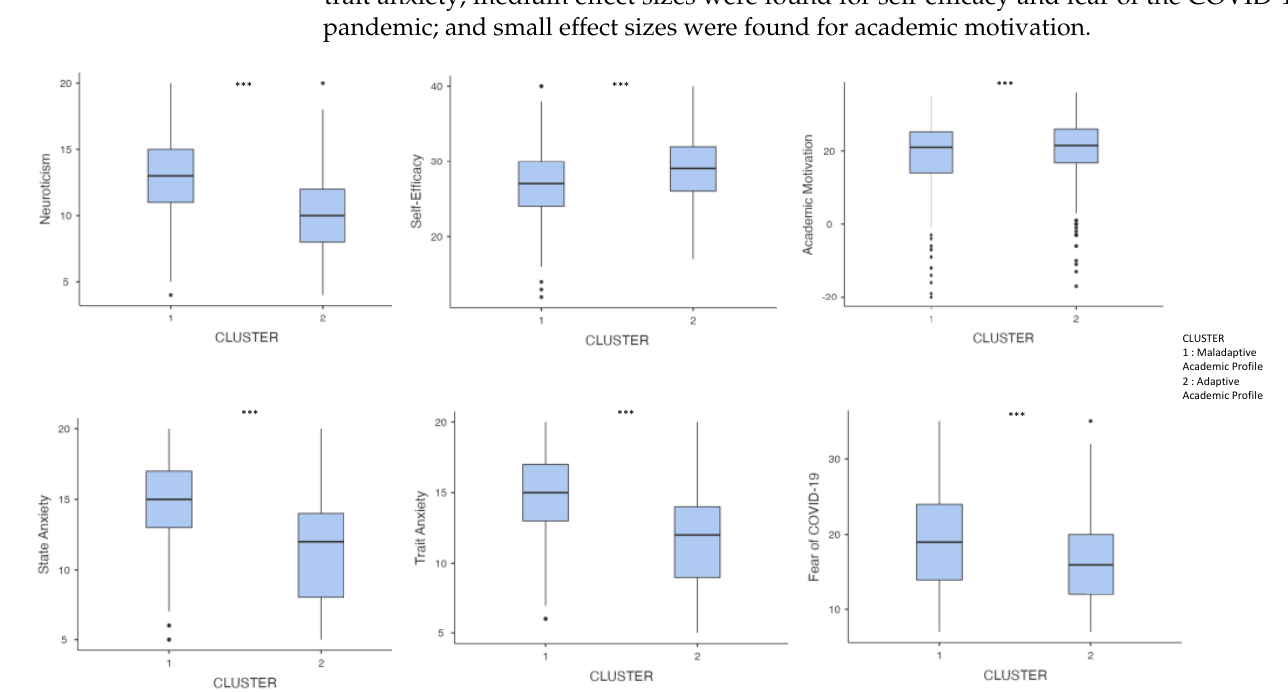
Figure 2. Plot of the between-group (Maladaptive and Adaptive Academic Profiles) differences on dependent variables. Note: *** p < 0.001.